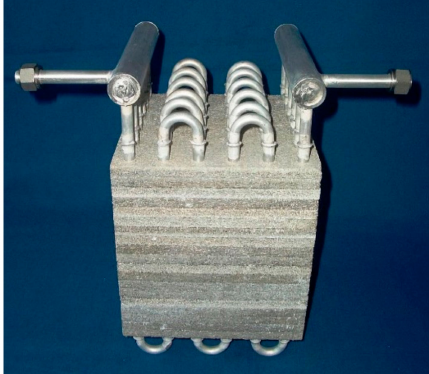
Figure 20. Photography of latent heat storage (without housing) before filling with PCM. Total fiber structure volume 8 L, dimensions of the fiber structure 200 mm × 200 mm × 200